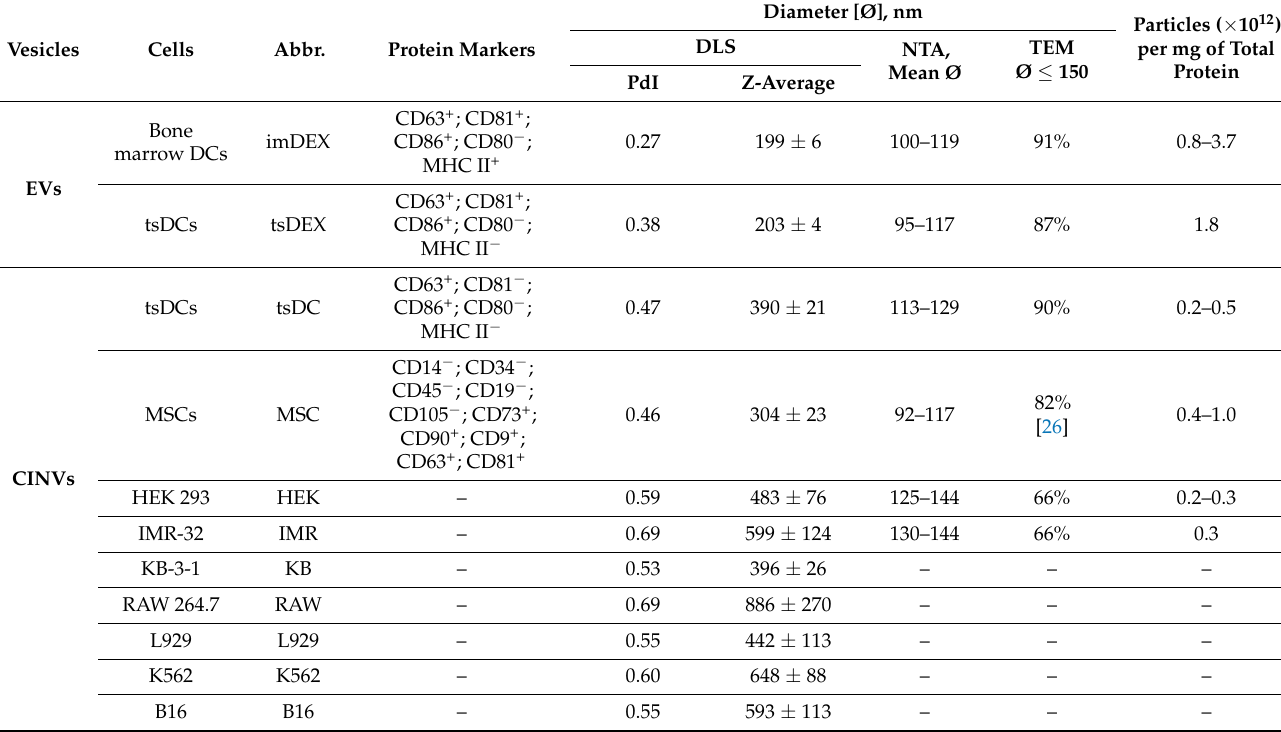
Table 1. Characteristics of EVs and CINVs used in this